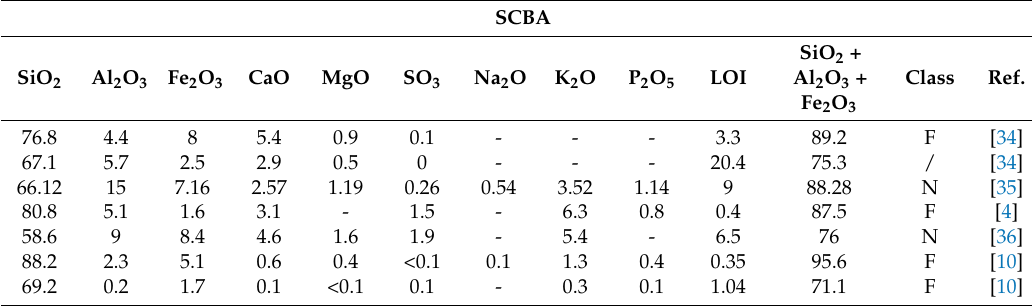
Table 1. Chemical composition of SCBA, in